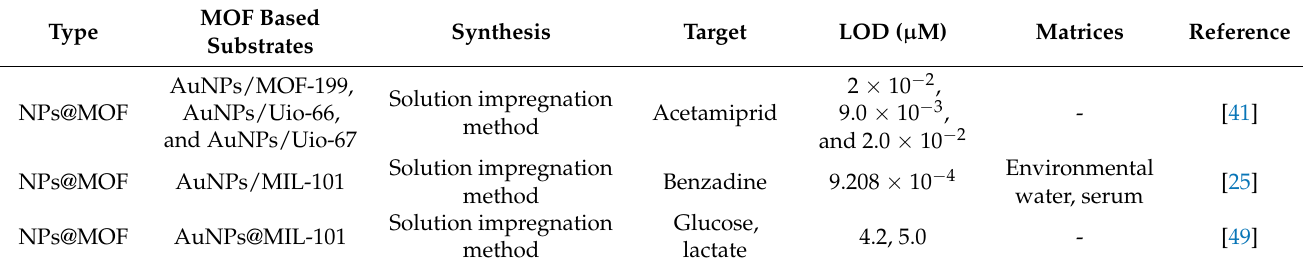
Table 1. Application of SERS-active NPs embedded MOF composites in SERS